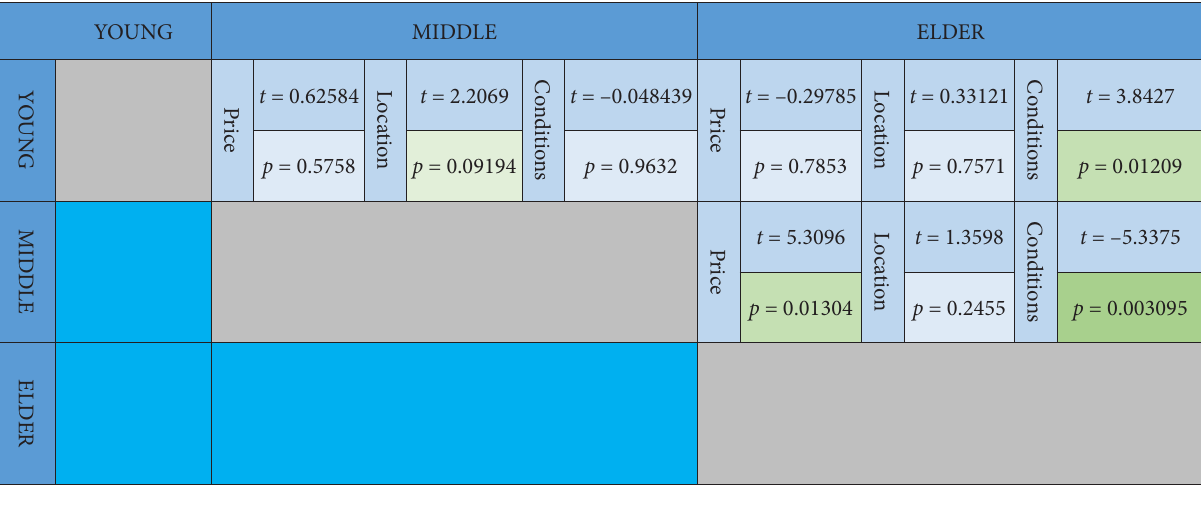
Table 8. Opinions of different income levels under each